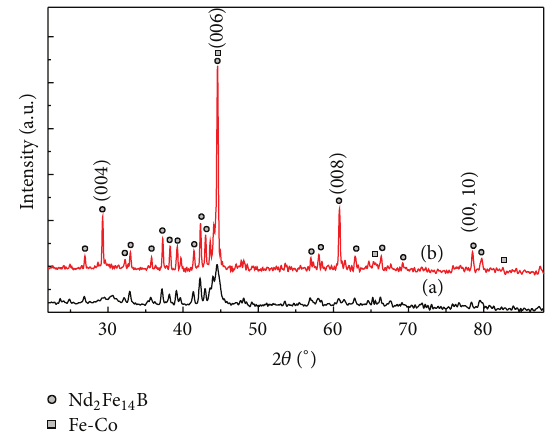
Figure 2: XDR patterns of Nd 16 Fe 76 B 8 /40%wt. Fe 65 Co 35 ribbons taken on their free surface: (a) the ribbon melt-spun without the assisted magnetic field and (b) the ribbon with the assisted magnetic field of 0.32 T.